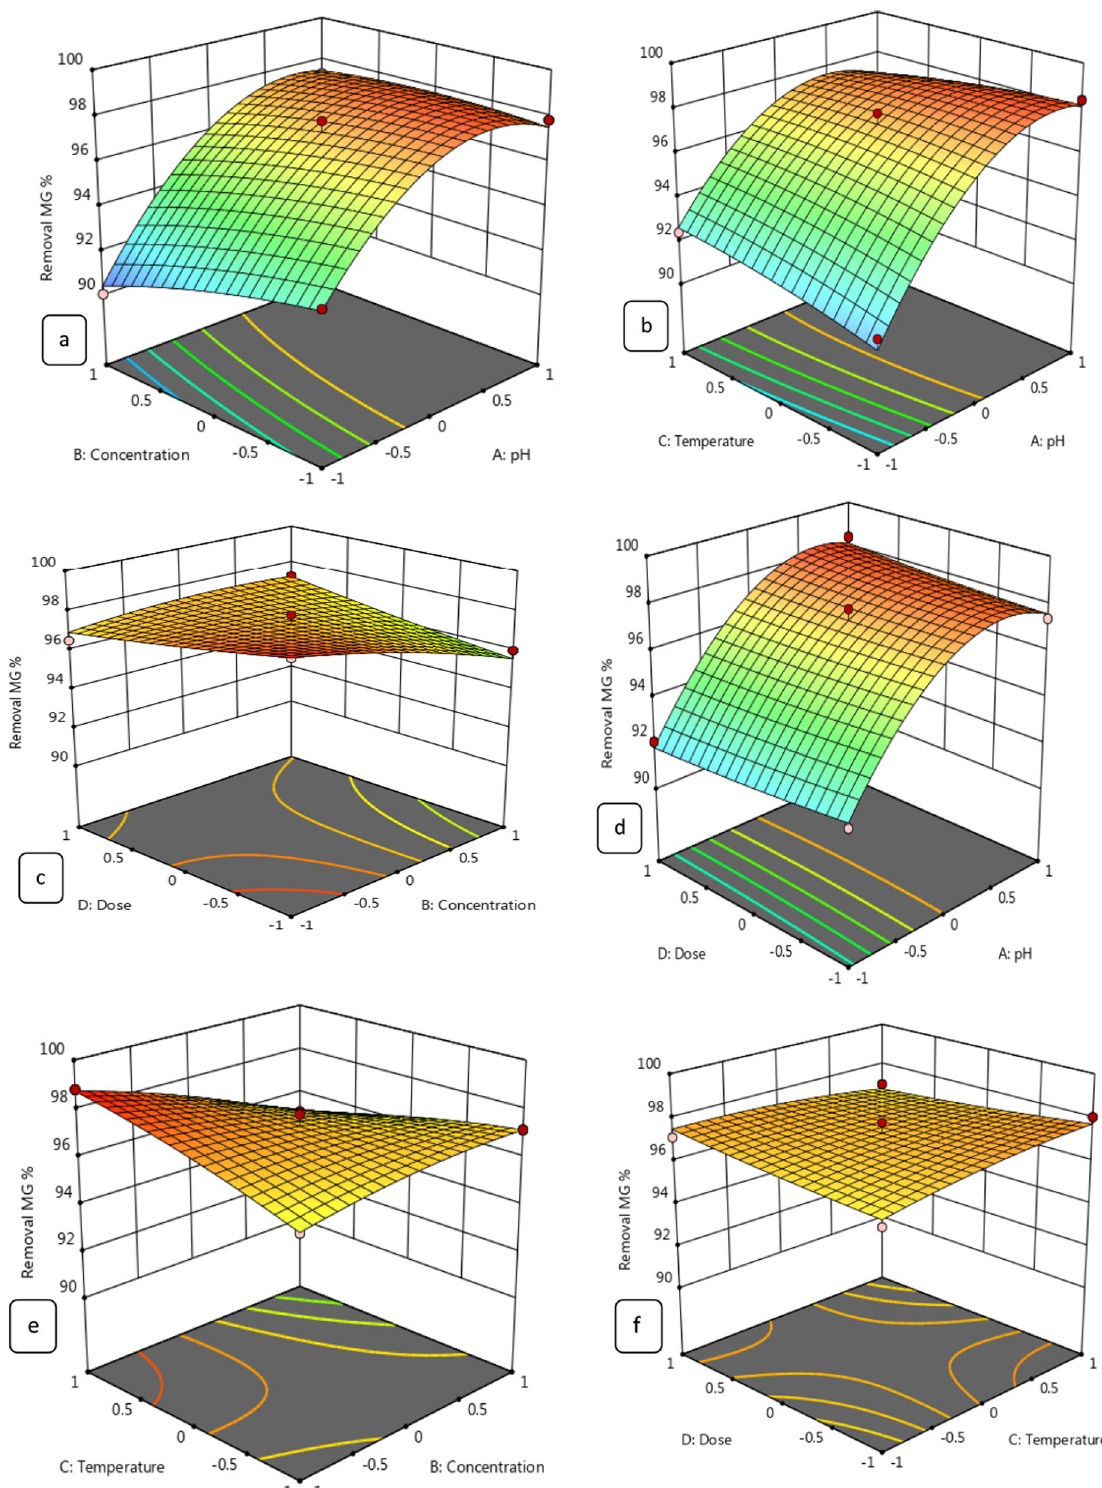
Fig. 12. 3D response surface plot of MG removal % through nano-bentonite as a function of pH, temperature and adsorbent